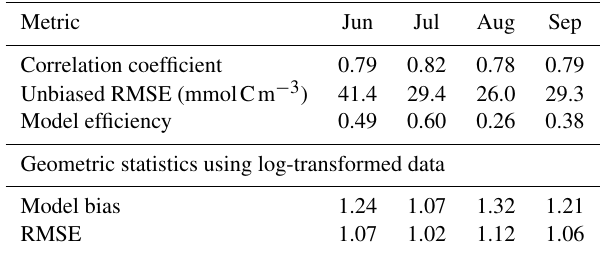
Table 1. Skill metrics of comparison computed based on the 2003– 2011 monthly climatologies of